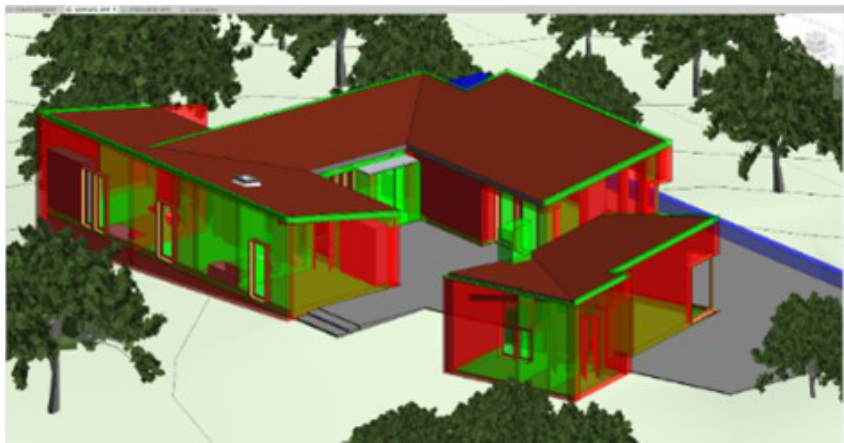
Figure 6. Level(GWP) analysis complete 3D results for a